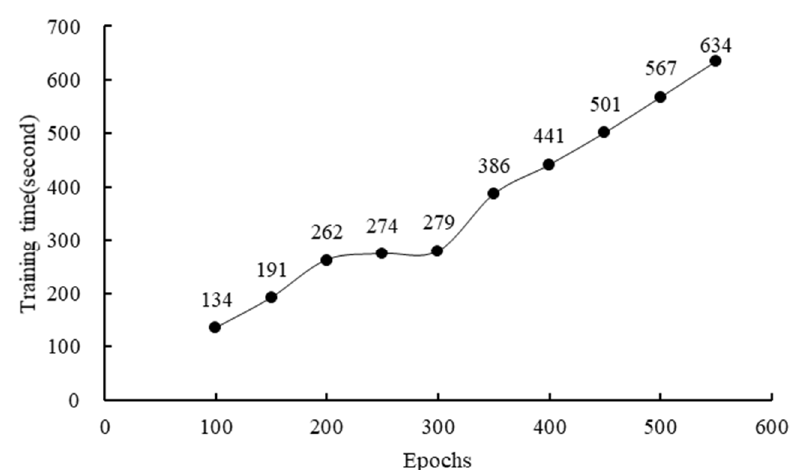
Figure 6. The relationship between training time and epochs.